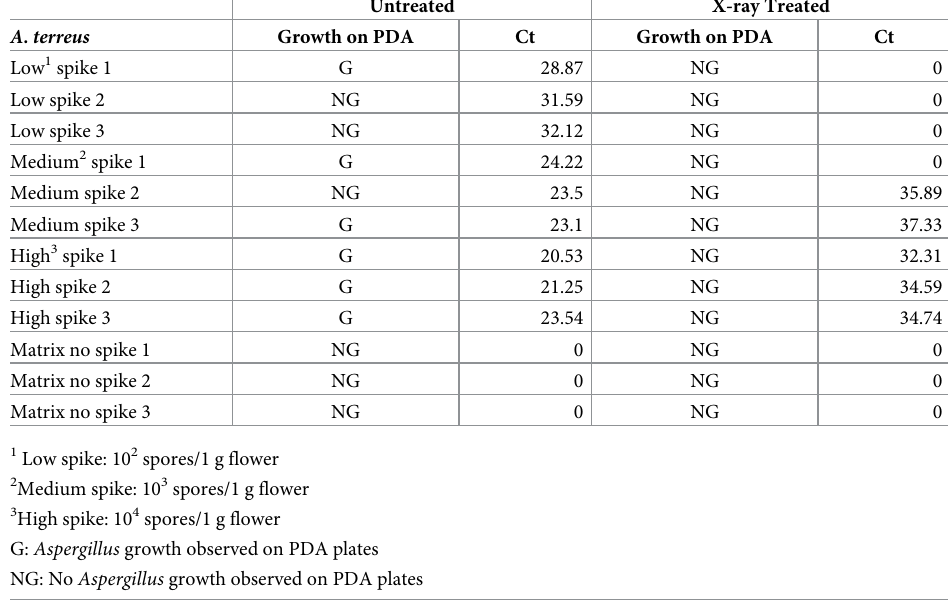
Table 6. PCR detection and viability of A . terreus at various spike levels, treated or untreated with 2.5 kGy of X- ray irradiation. Untreated X-ray Treated A . terreus